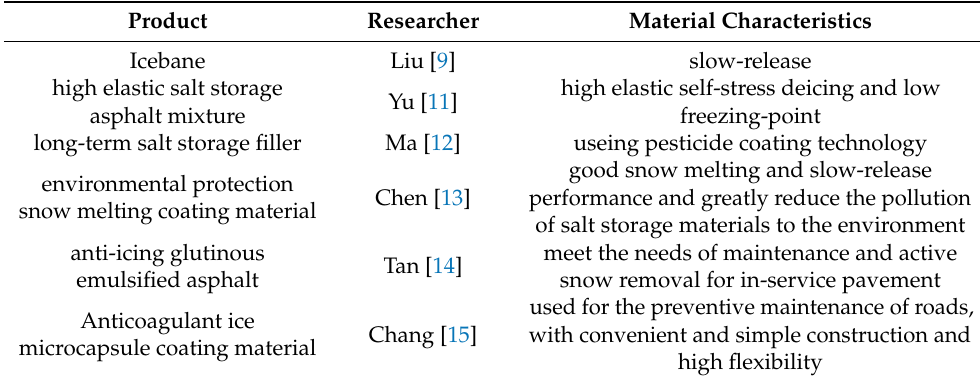
Table 1. Domestic research and development of anti-icing product. Product Researcher Material